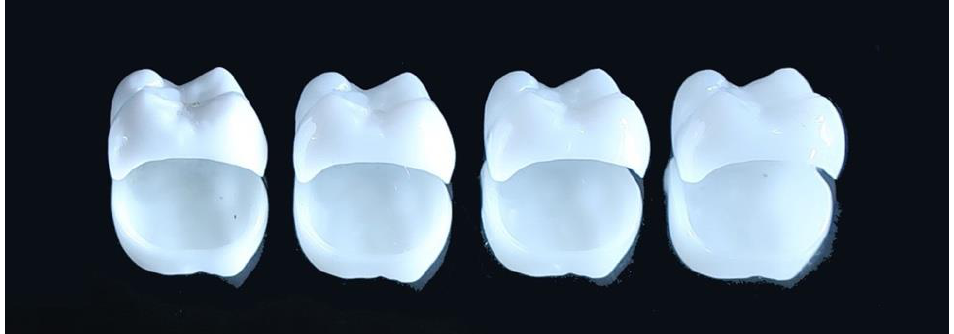
Figure 3. Monolithic zirconia posterior crowns. From the left, 3Y-HA, 3Y, 4Y, and 5Y zirconia. Translucency increases with yttria content.